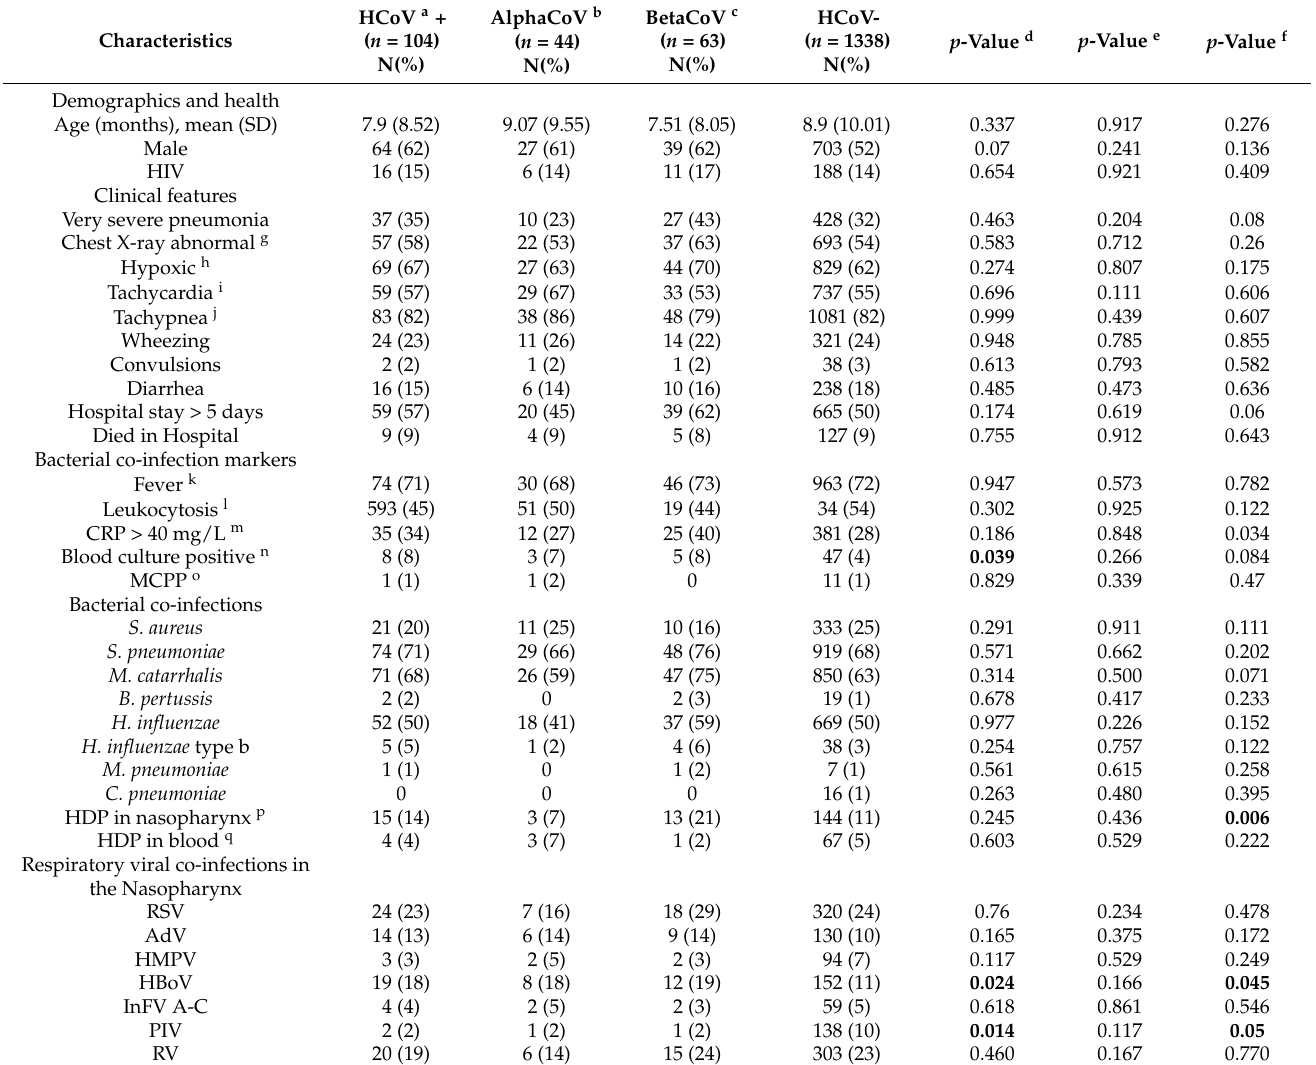
Table 3. Demographic, clinical characteristics and markers of bacterial and respiratory viral co-infections among severe and very-severe pneumonia cases identified with Human coronavirus